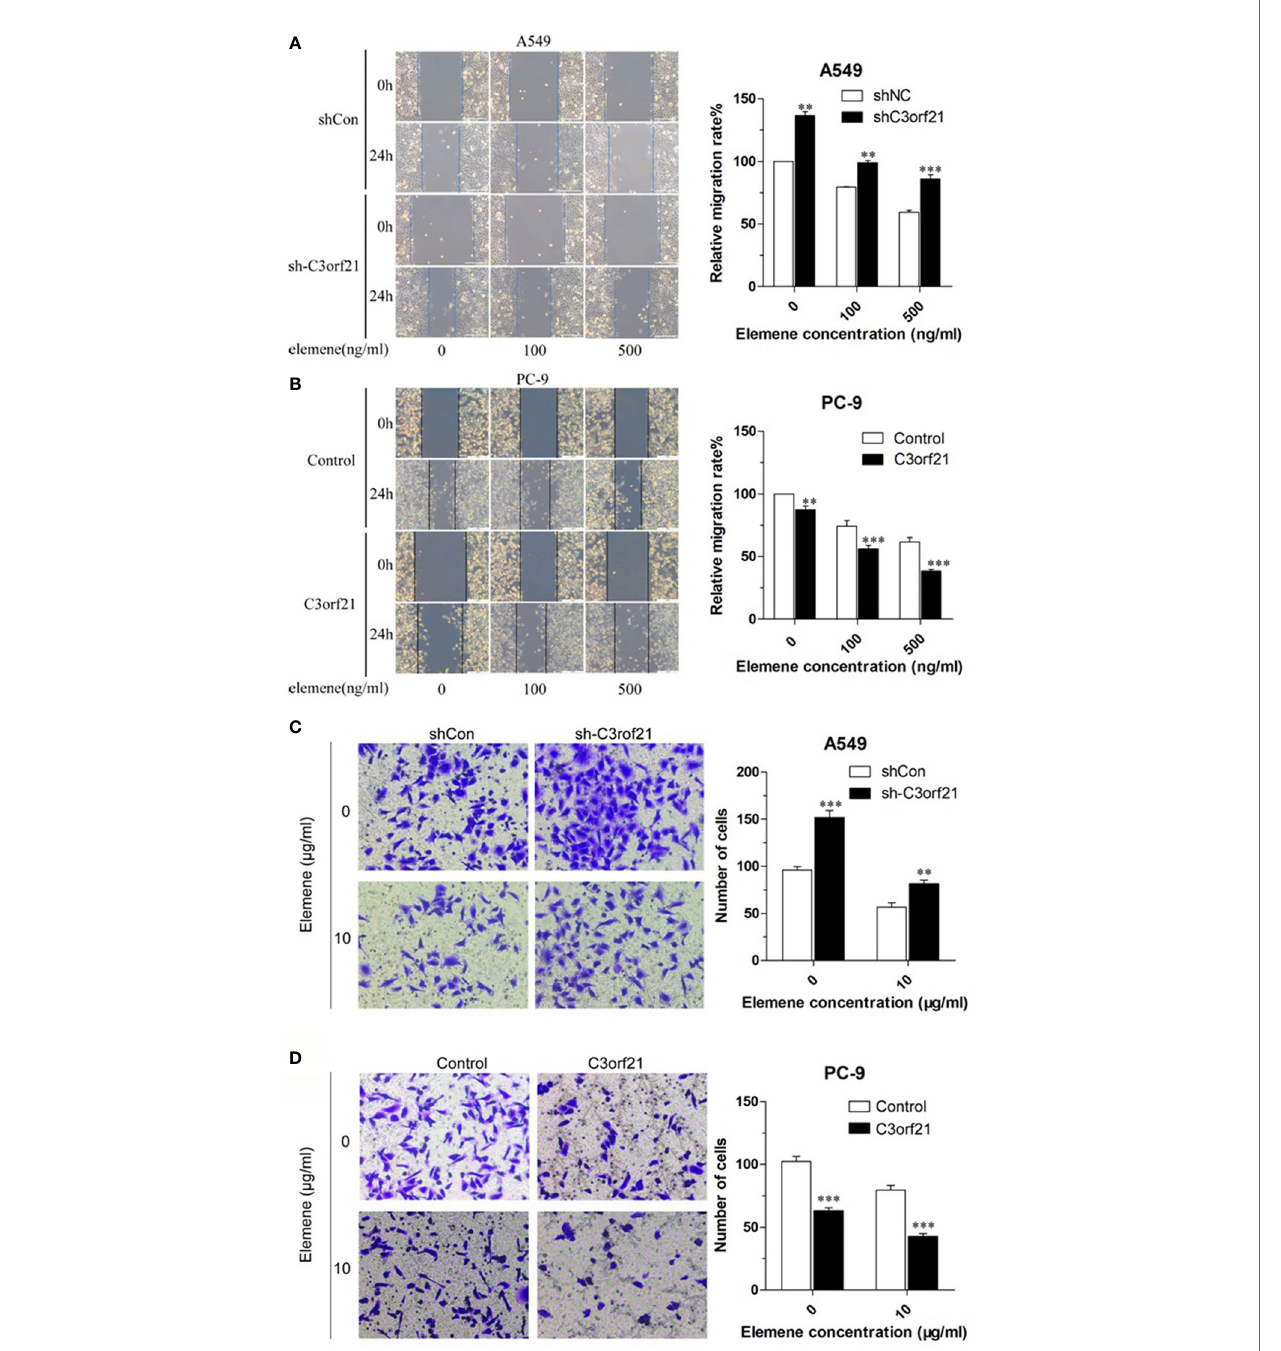
FIGURE 6 | Beta-elemene attenuates the wound healing and invasion of NSCLC cells. (A) The wound healing of A549 cells. (B) The wound healing of PC-9 cells. (C) The invasion of A549 cells. (D) The invasion of PC-9 cells. Data are representative images or expressed as the mean ± SD of each group from three biological experiments. **P < 0.01 and ***P < 0.001 vs. the